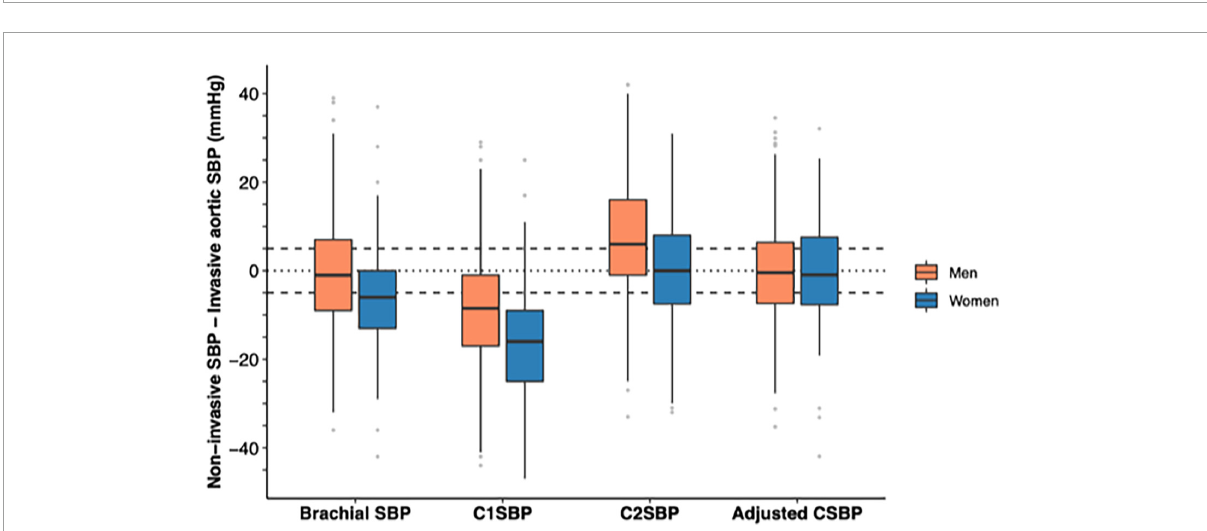
FIGURE3 Differences between brachial SBP/estimated central SBP and invasive aortic SBP by sex before and after adjustment. The distribution of differences by sex strata are displayed by boxplots before and adjustment (full model). The horizontal black line in the middle of each box indicates the median, the square extremities indicate the interquartile range, and the vertical black lines end at either the minimum (first quartile minus 1.5 times the interquartile range) or the maximum (third quartile plus 1.5 times the interquartile range). Gray dots indicate outliers. The full models include the age, sex, heart rate, estimated SBP amplification, pulse wave velocity, augmentation index at 75 bpm, reflection magnitude, height, weight, eGFR, active smoking, diabetes, antihypertensive treatment. C1SBP, Type I calibrated central SBP; C2SBP, Type II calibrated central SBP; eGFR, estimated glomerular filtration rate; SBP, Systolic blood